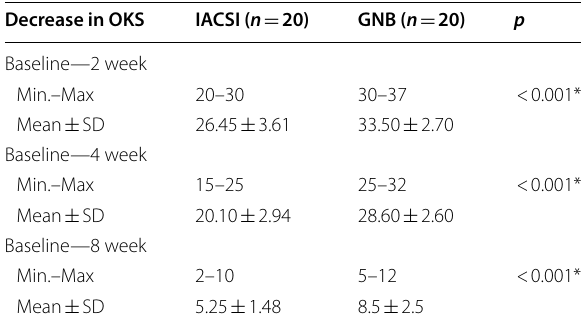
Table 5 Comparison between GNB and IACSI groups according to decrease in OKS from